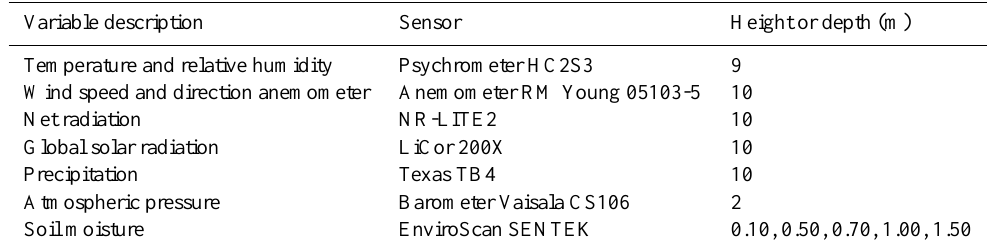
Table 2. Data collected at the IAB